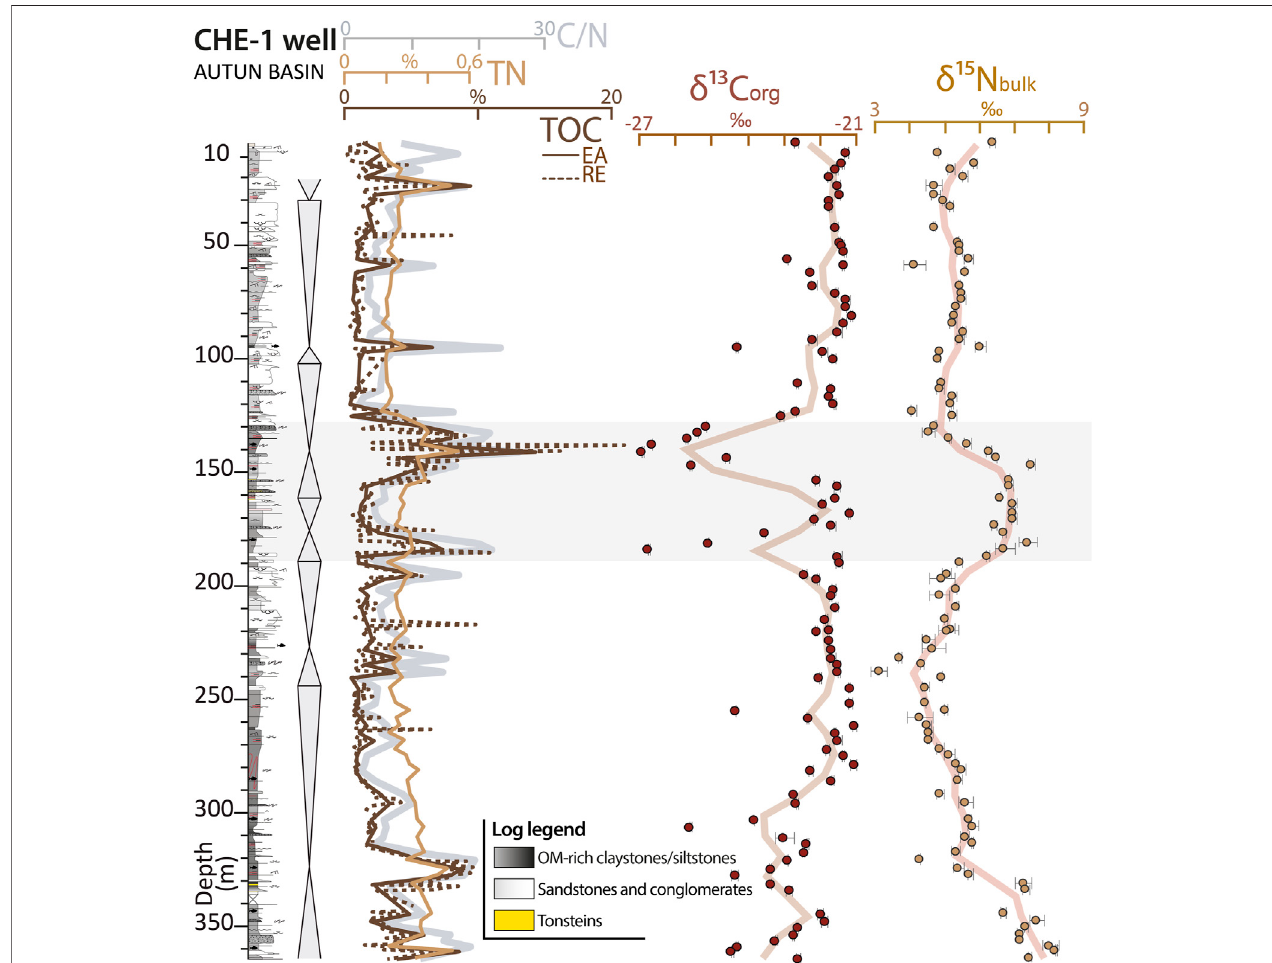
FIGURE4| Sedimentarysection,sequencestratigraphyoftheCHE-1core(AutunBasin)andorganicsignalevolution(totalorganiccarbonTOC,totalnitrogenTN, C/N atomic ratio, δ 13 C org and δ 15 N bulk variations). The log caption is displayed on Figure 2 . RE, Rock-Eval pyrolysis.